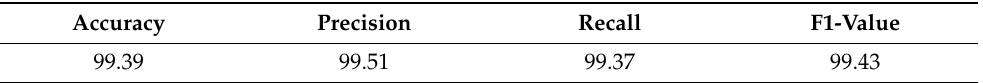
Table 7. The result of the model on evaluation indicators of validation set